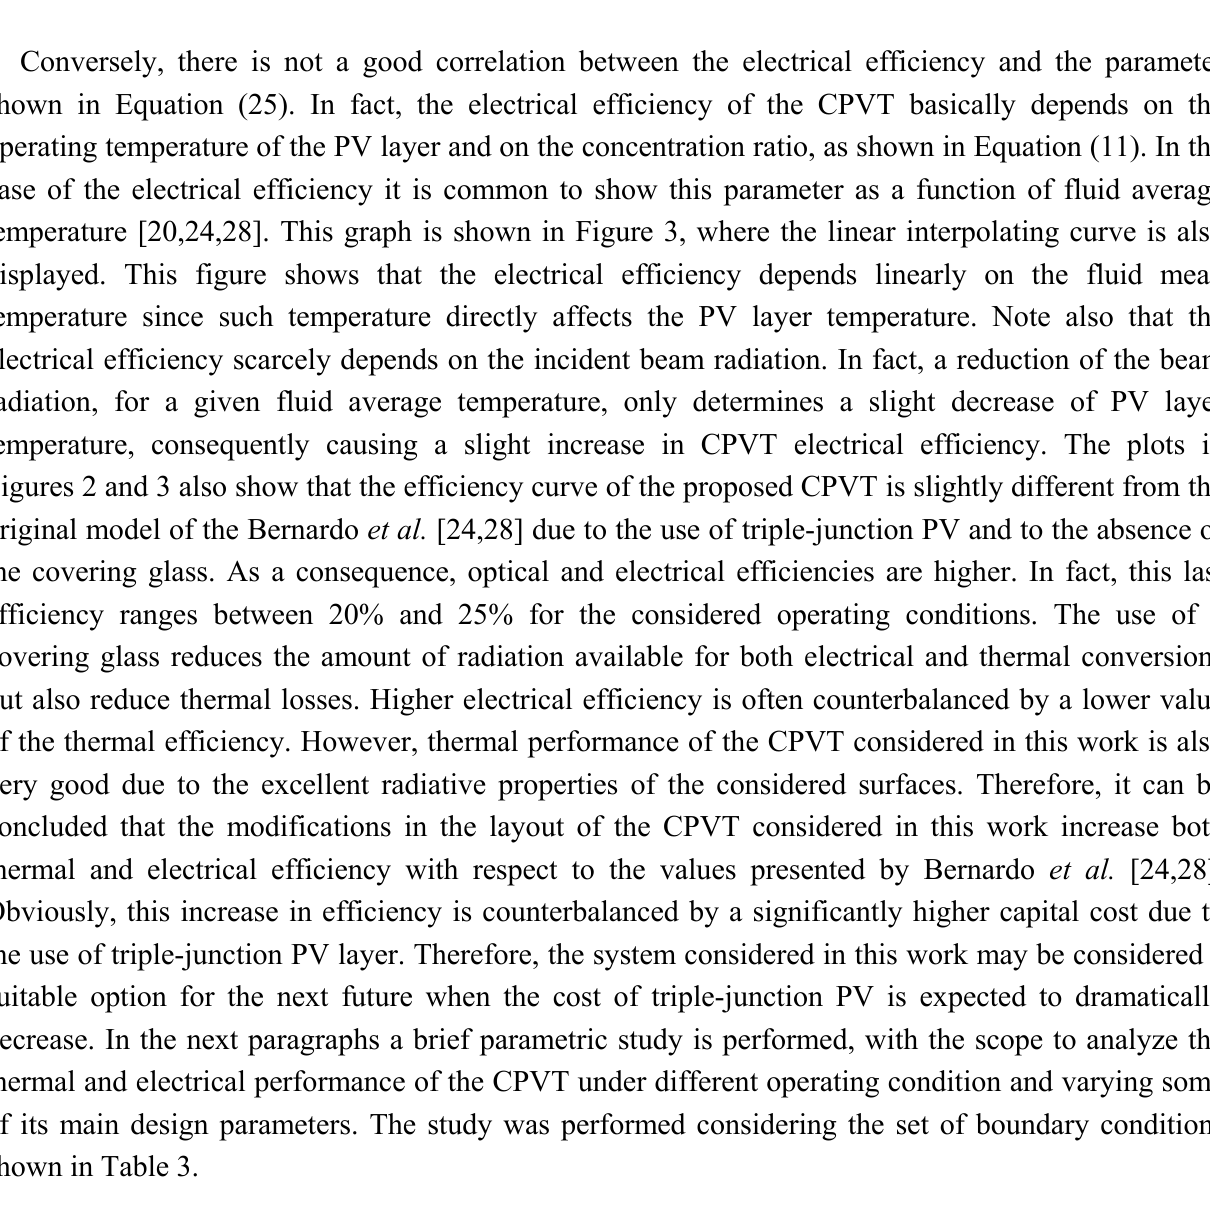
Figure 3. CPVT electrical